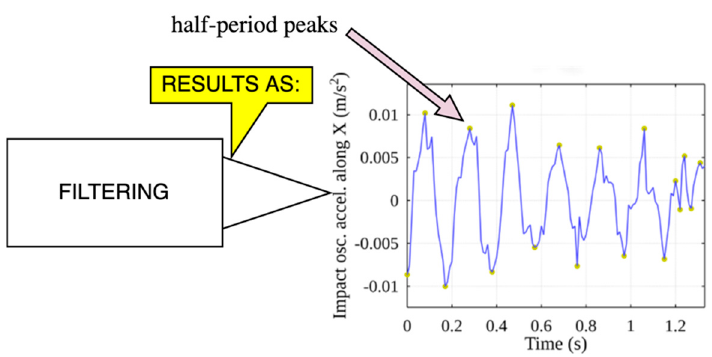
Figure 3. Signal filtering process deconstruction with exclusion points.